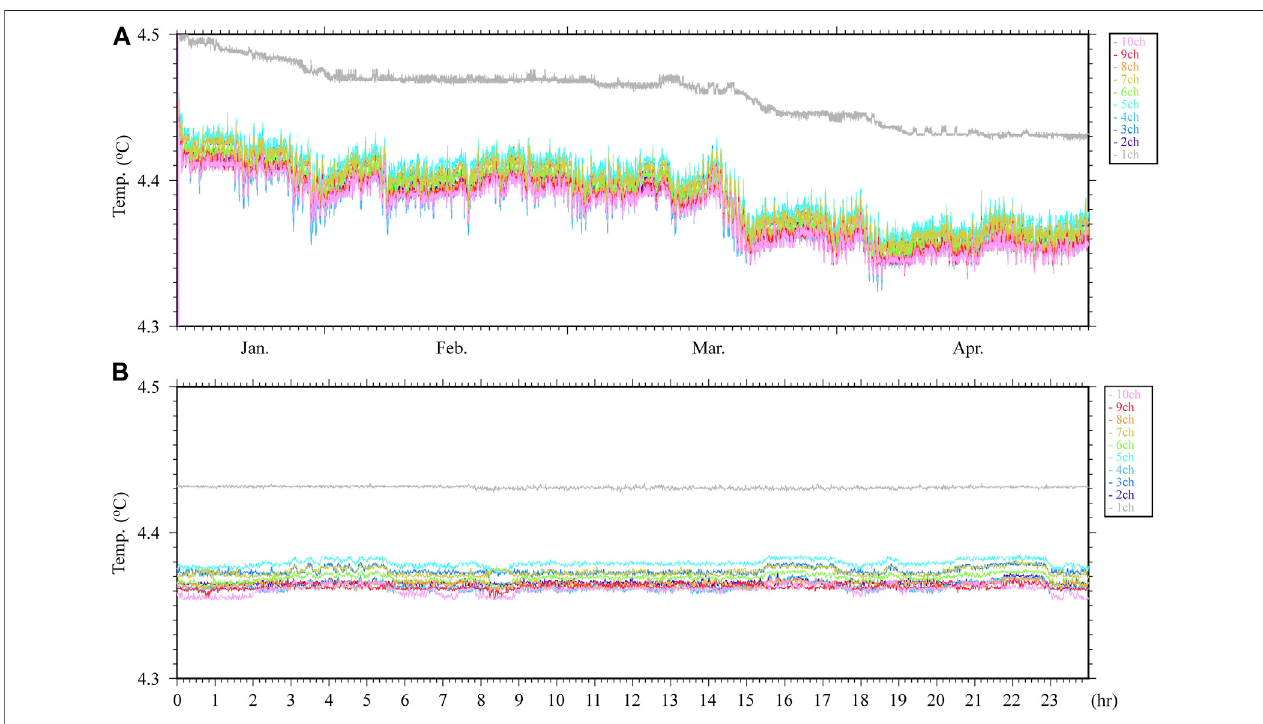
FIGURE 9 | (A) Time series of the temperature variation measured using a 10-channel thermometer during the whole observation period (B) Same as A, but with data of April 30, 2018.